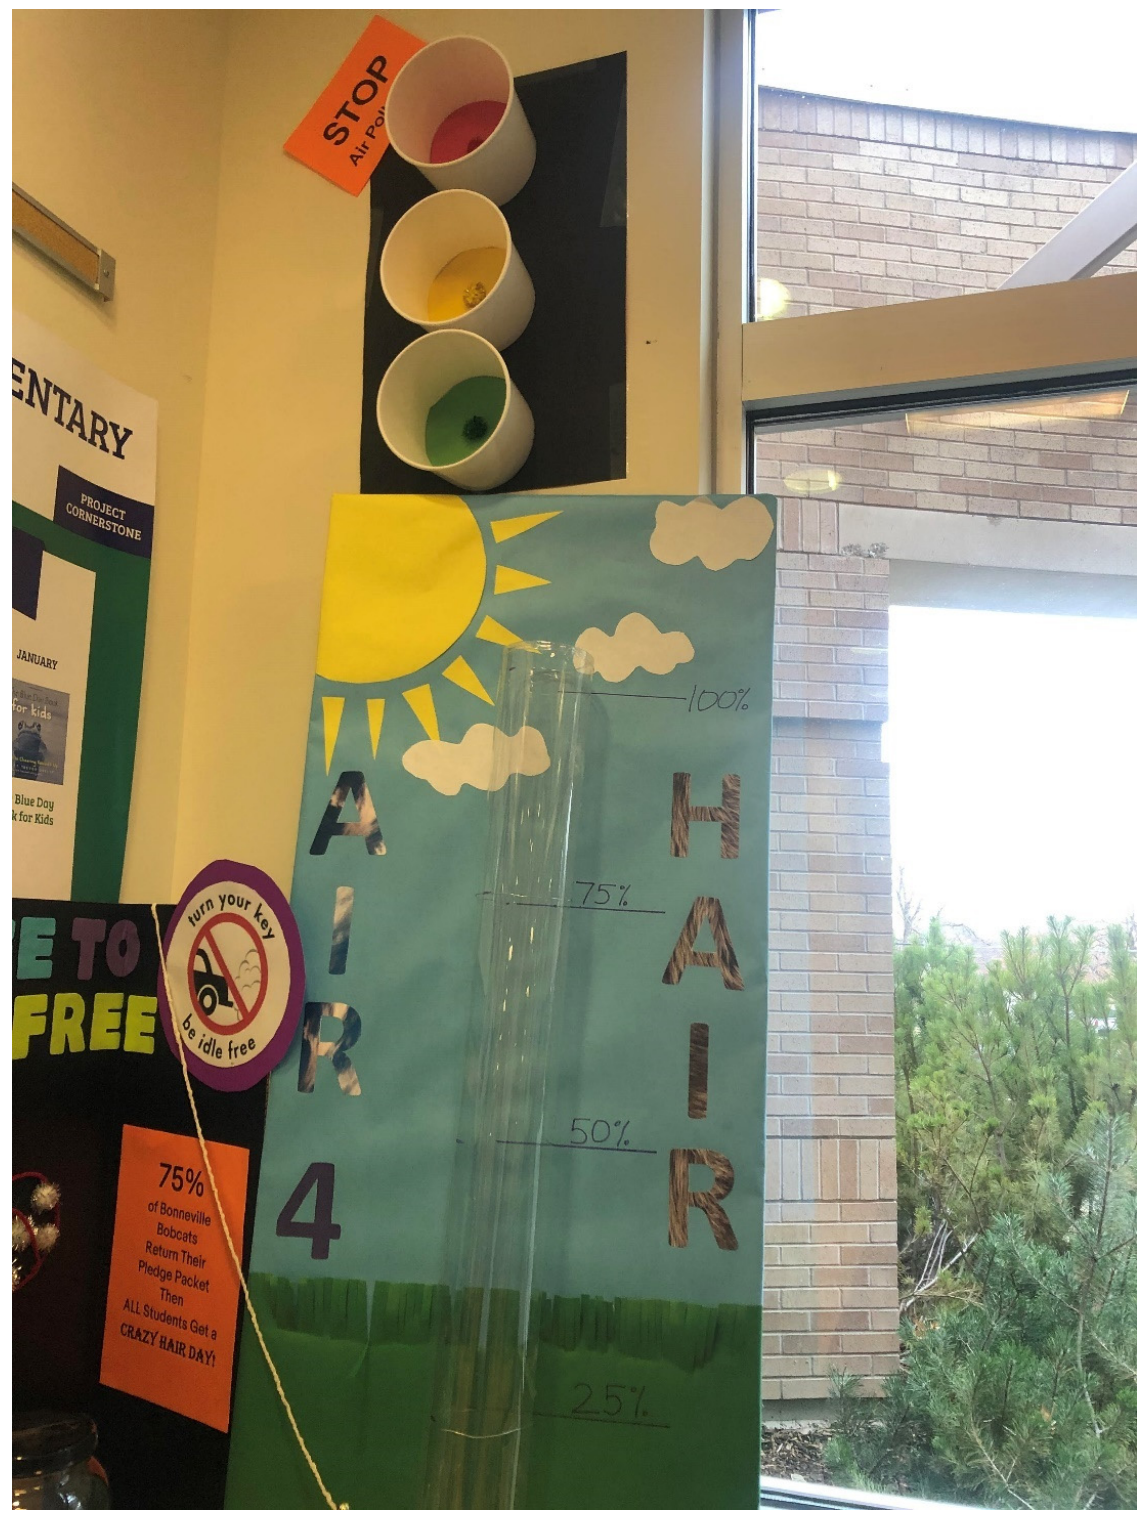
Figure A14. Display at school foyer tracking progress of returned pledge forms.